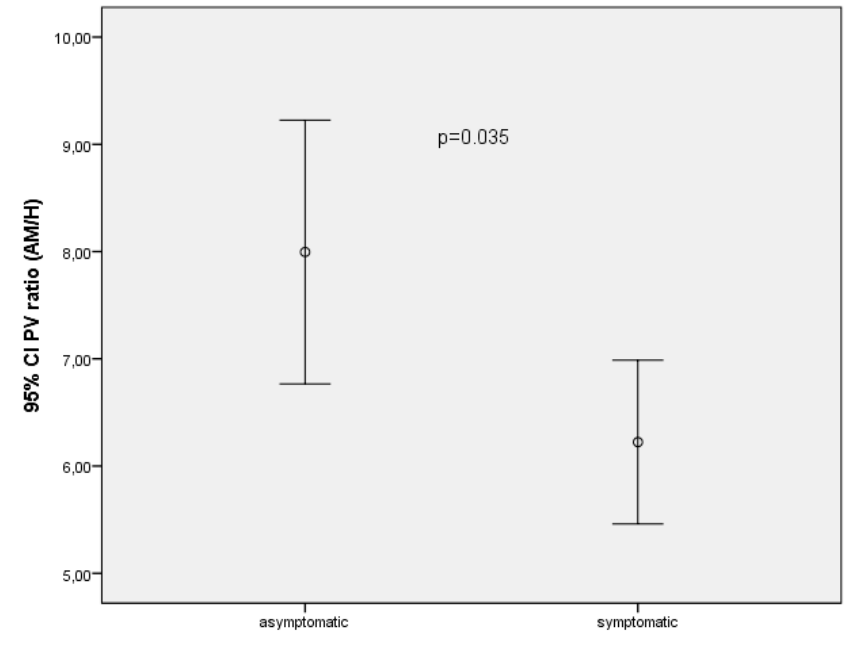
Figure 2 . Comparison of 95% confidance intervals (CI) of peak velocity ratios (hilar/aortomesenteric portion) levels in asymptomatic and symptomatic patients.